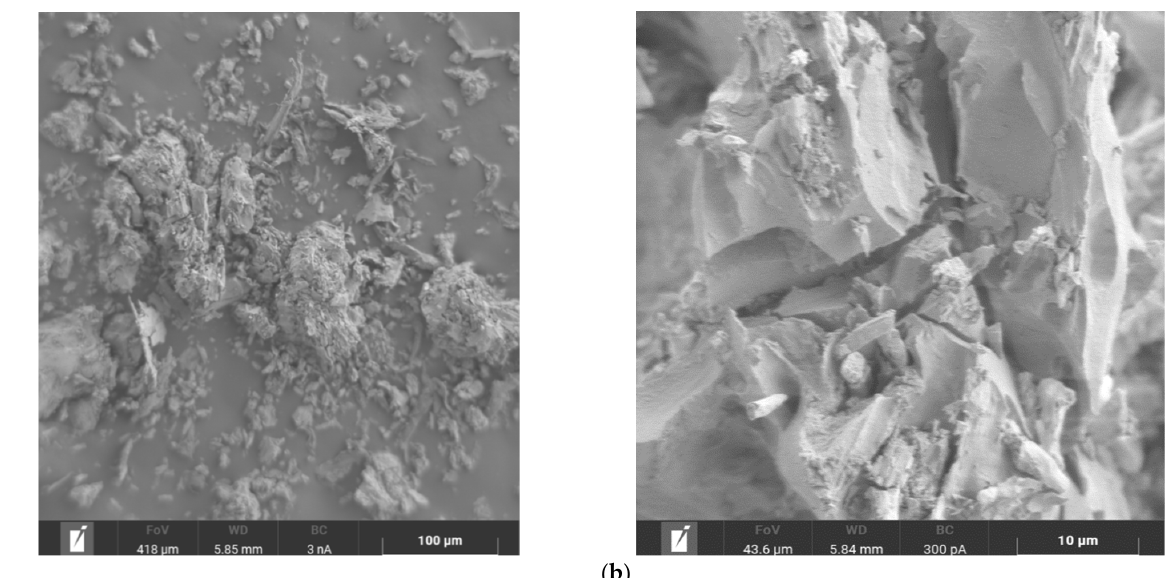
Figure 2. SEM micrographs of thermolysis productsof samble I —( a ), for samble II —( b ).